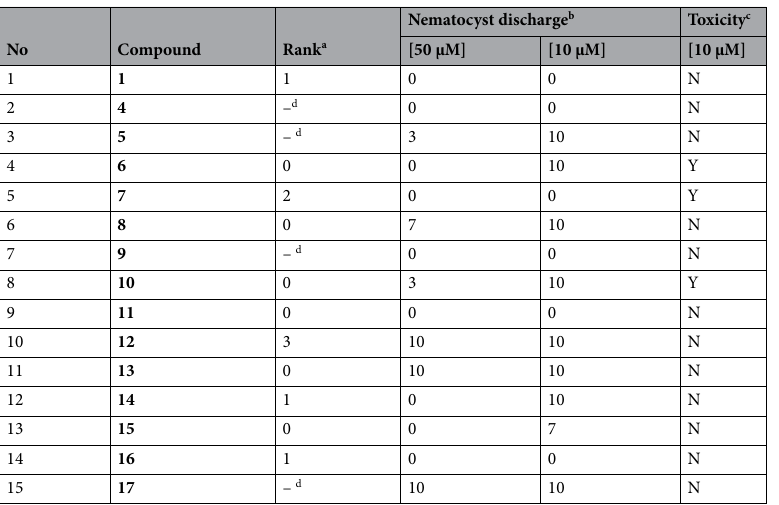
Table 1. Structure–activity relationships of [2.2]paracyclophane derivatives. a Indication after primary assay (10 µM): 0 = no prey capture in all animals tested (highly active) to 3 = prey capture in all animals as in control (no activity). b Observations were recorded as means of biological triplicates using a well of 10 animals according to 0 = nematocyst discharge in no animal (high effect) to 10 = nematocyst discharge in all animals (no effect). c Toxicity was recorded after 24 h at a concentration of 10 µM: Y = toxicity observed, N = no toxicity observed; toxicity included categories 2–5 (see figure legend Fig. 1). d Was not included in the primary